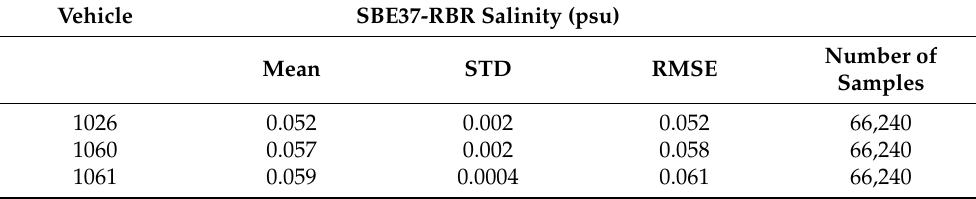
Table 1. Mean difference, standard deviation difference (STD) and root mean squared error (RMSE) between each saildrone’s SBE and RBR instruments used to retrieve salinity from the western Tropical